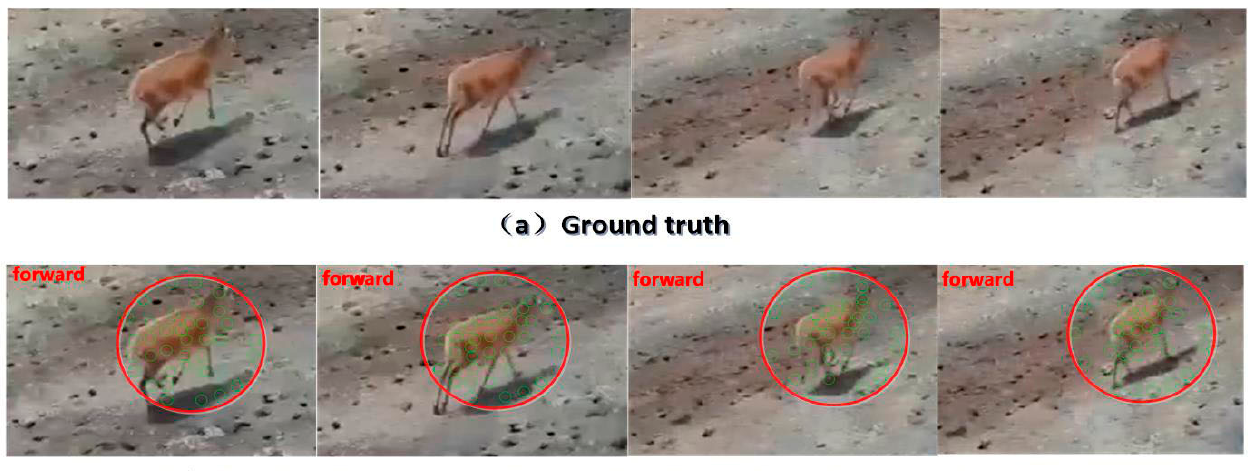
Figure 8. Comparison between ground truth and output of the algorithm for verification.